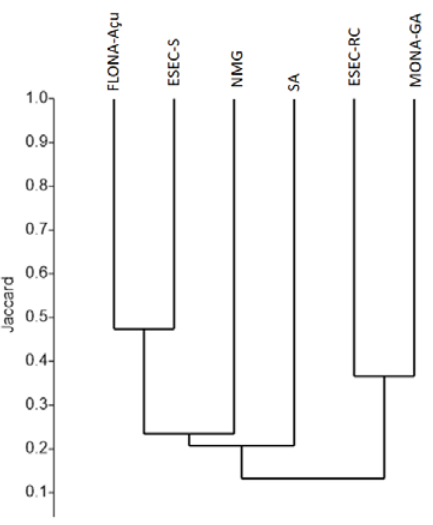
Figure 3. Clustering of the similarity (Jaccard dissimilarity index) of mosquito fauna in six areas of the